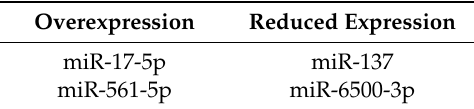
Table 4. Expression of particular miRNA molecules detected in pediatric HGG population compared with pediatric HGG